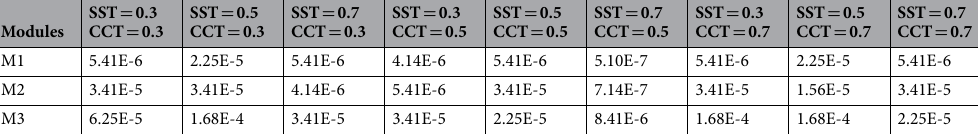
Table 1. p–value of top 3 modules obtained using different thresholds in metastasis stage.